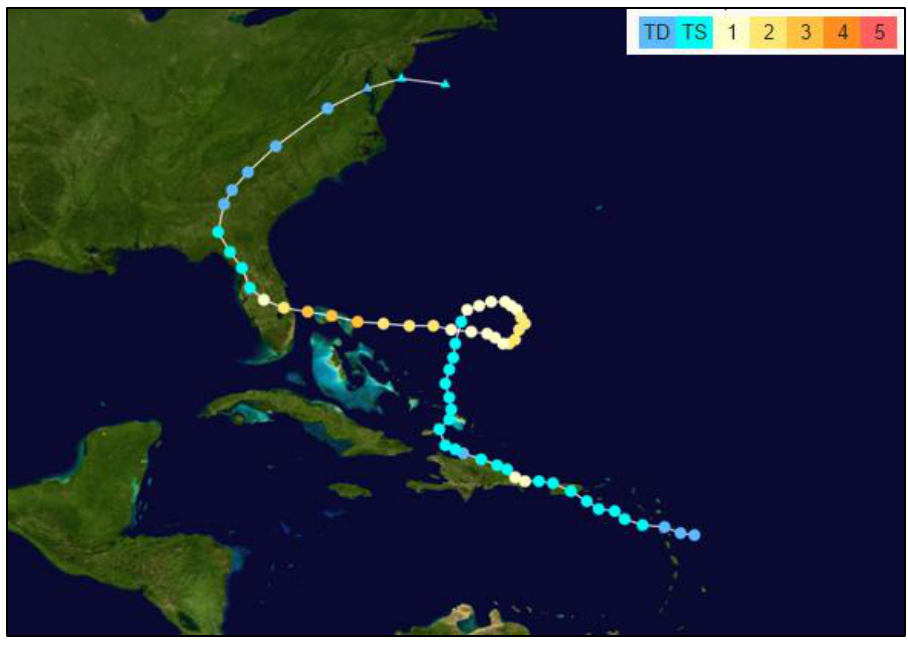
Figure 13. Track of Hurricane Jeanne (2004).